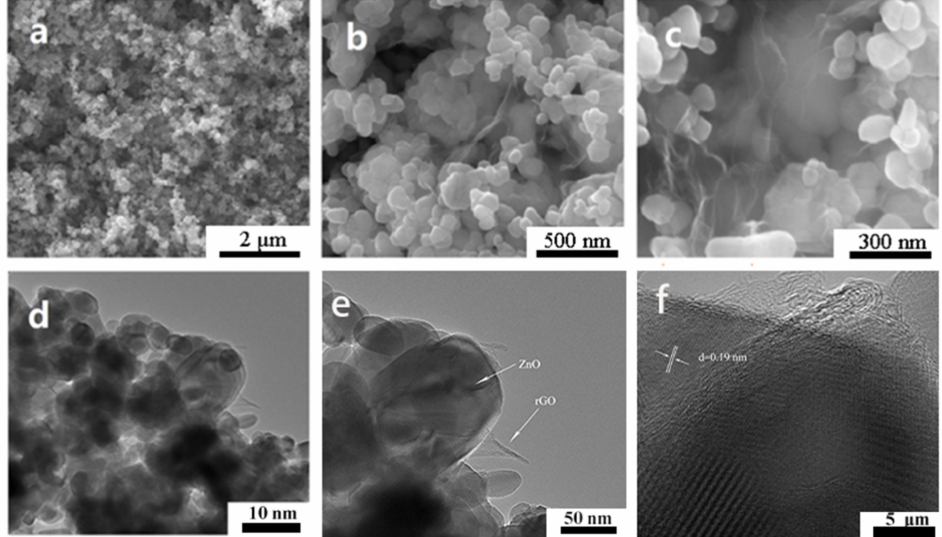
Figure 2. SEM images of ZnO antiparticles ( a ) and ZnO-0.2 rGO ( b , c ); TEM images of ZnO-0.2 rGO at low ( d , e ) and high ( f )